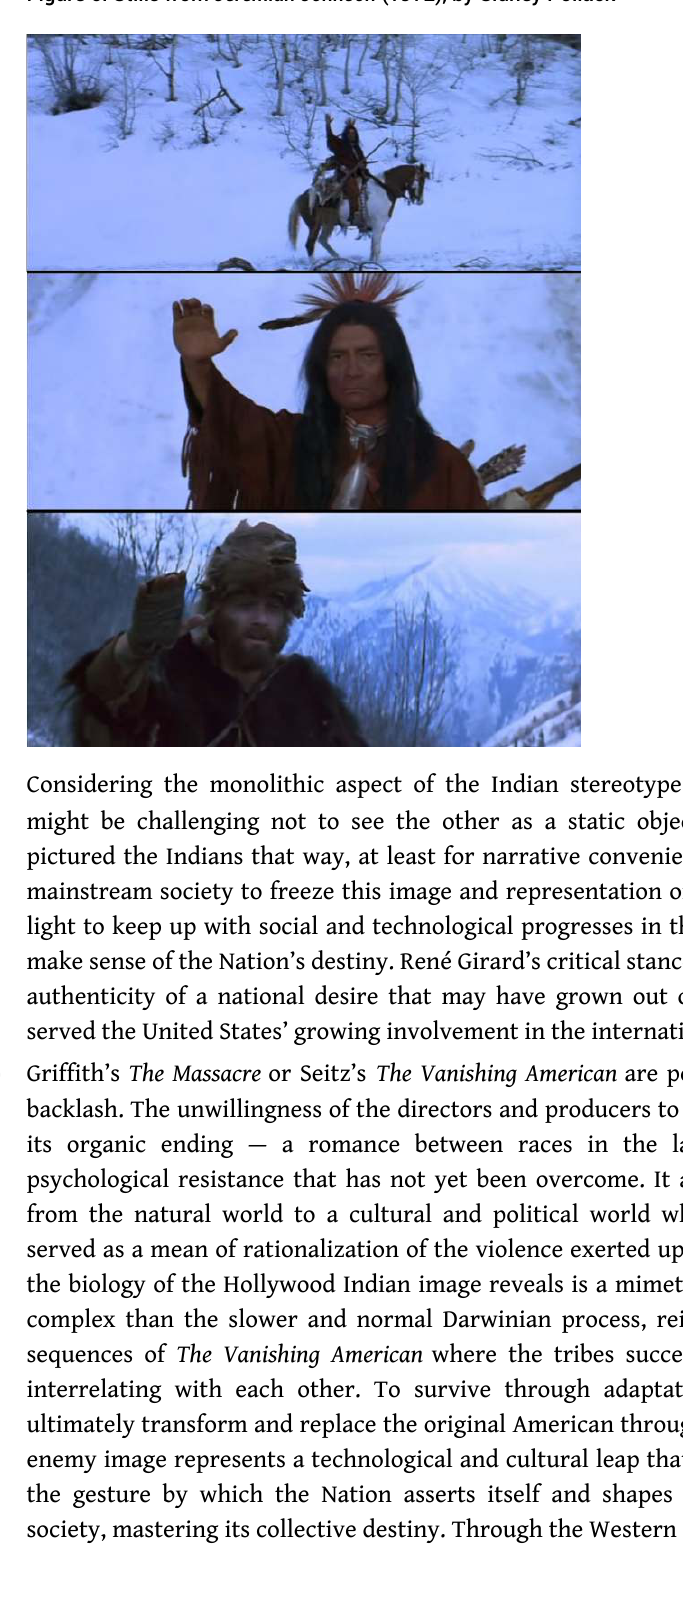
Figure 6. Stills from Jeremiah Johnson (1972), by Sidney